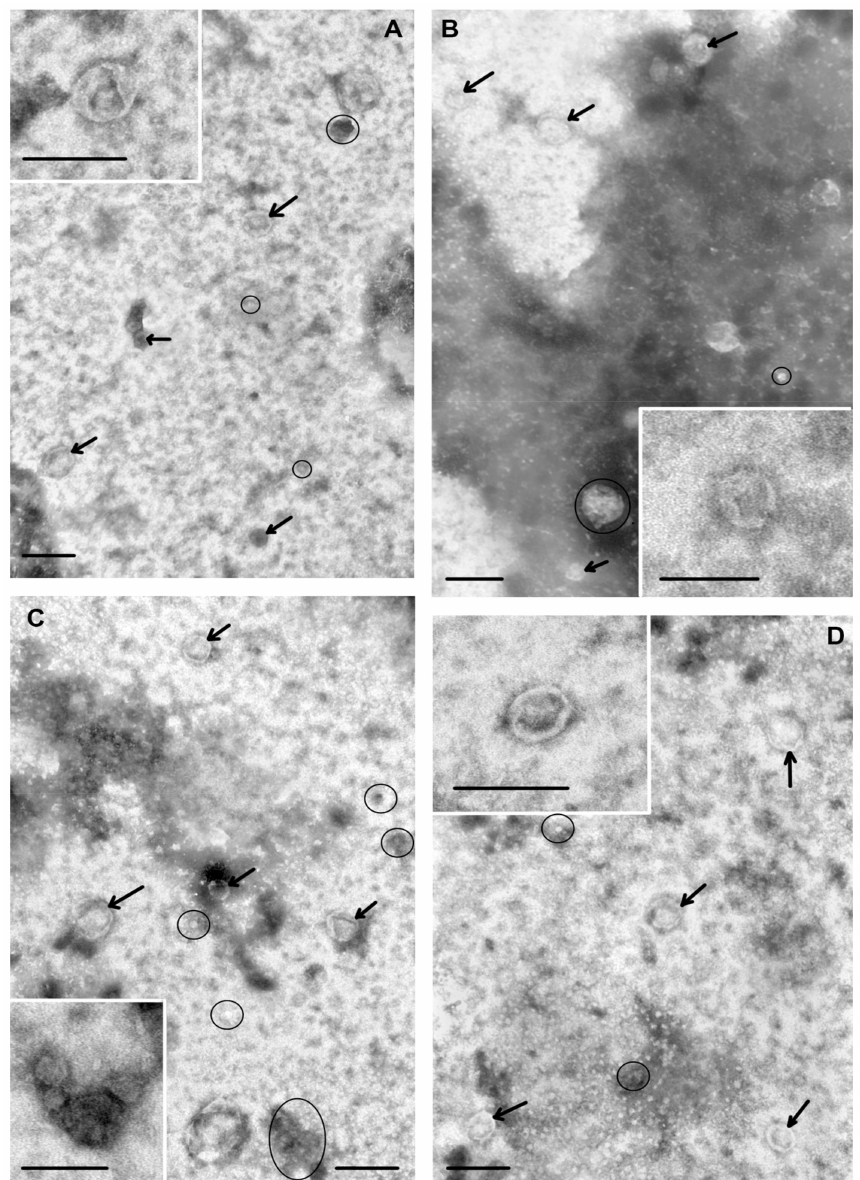
Figure 1. Total view of exosome preparation obtained from: blood plasma of HFs ( A ), blood plasma of BCPs ( B ), total blood of HFs ( C ), total blood of BCPs ( D ). Inserts show exosomes. Arrows indicate exosomes, ellipses—«non-vesicles». Scale bars correspond to 100 nm. Electron microscopy, negative staining by phosphotungstate